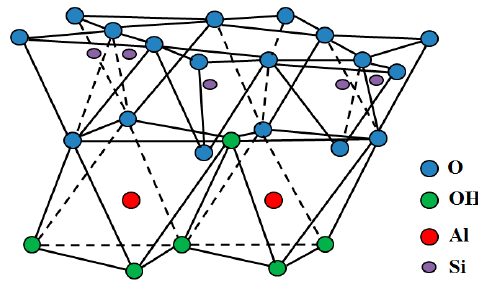
Figure 4. Crystalline structure of HNTs [46].